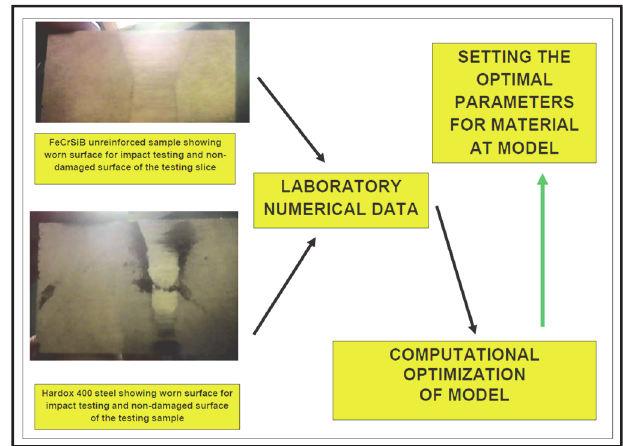
Fig. 13. Method for modelling development. From experimental lab data the cloud of numerical values is set within the model for computational optimization.